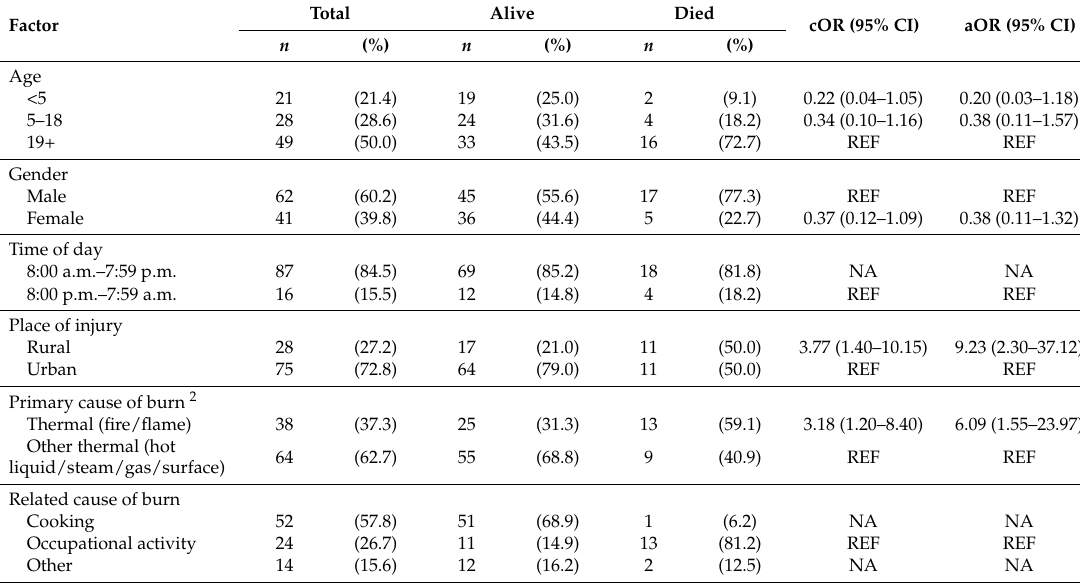
Table 4. Multivariate logistic regression predicting death 1